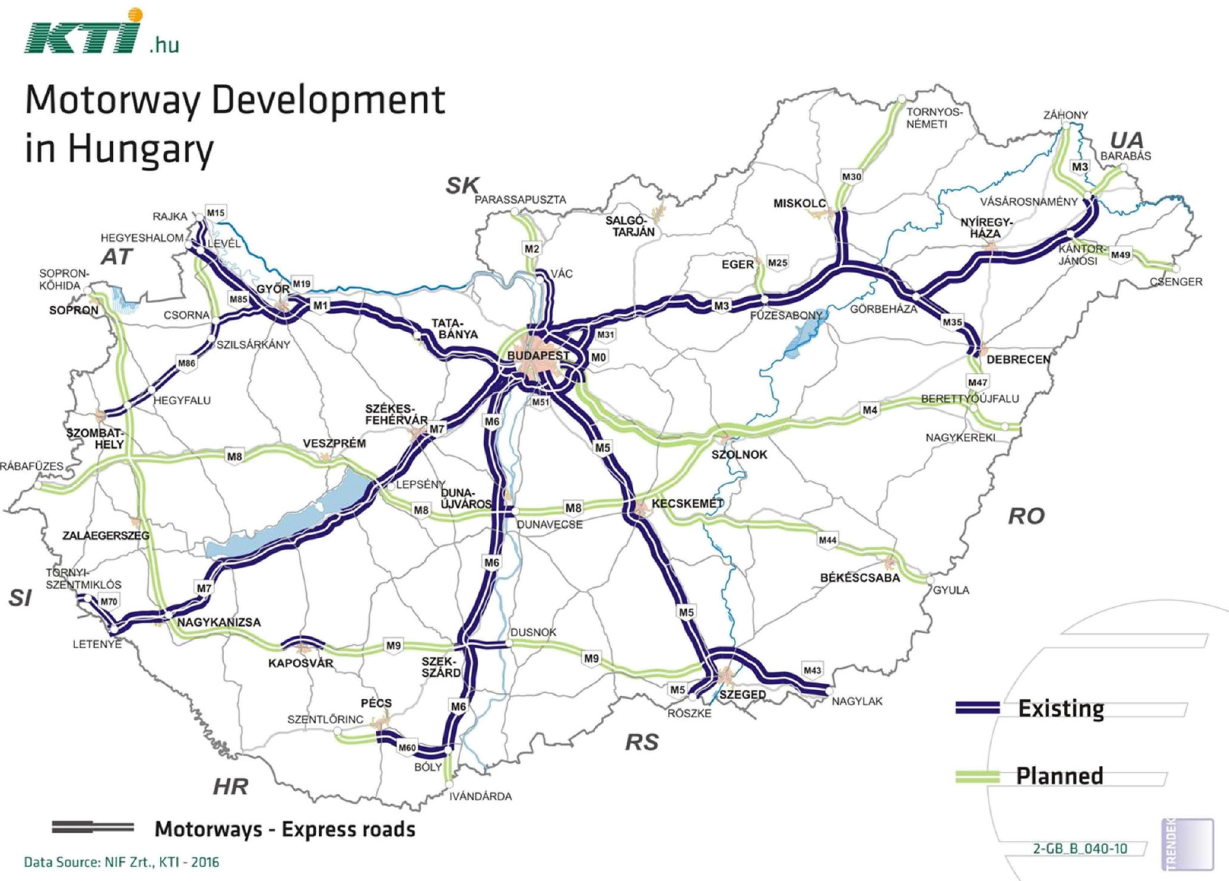
Fig. 2 The Motorway development and plans in Hungary (Source: NIF,